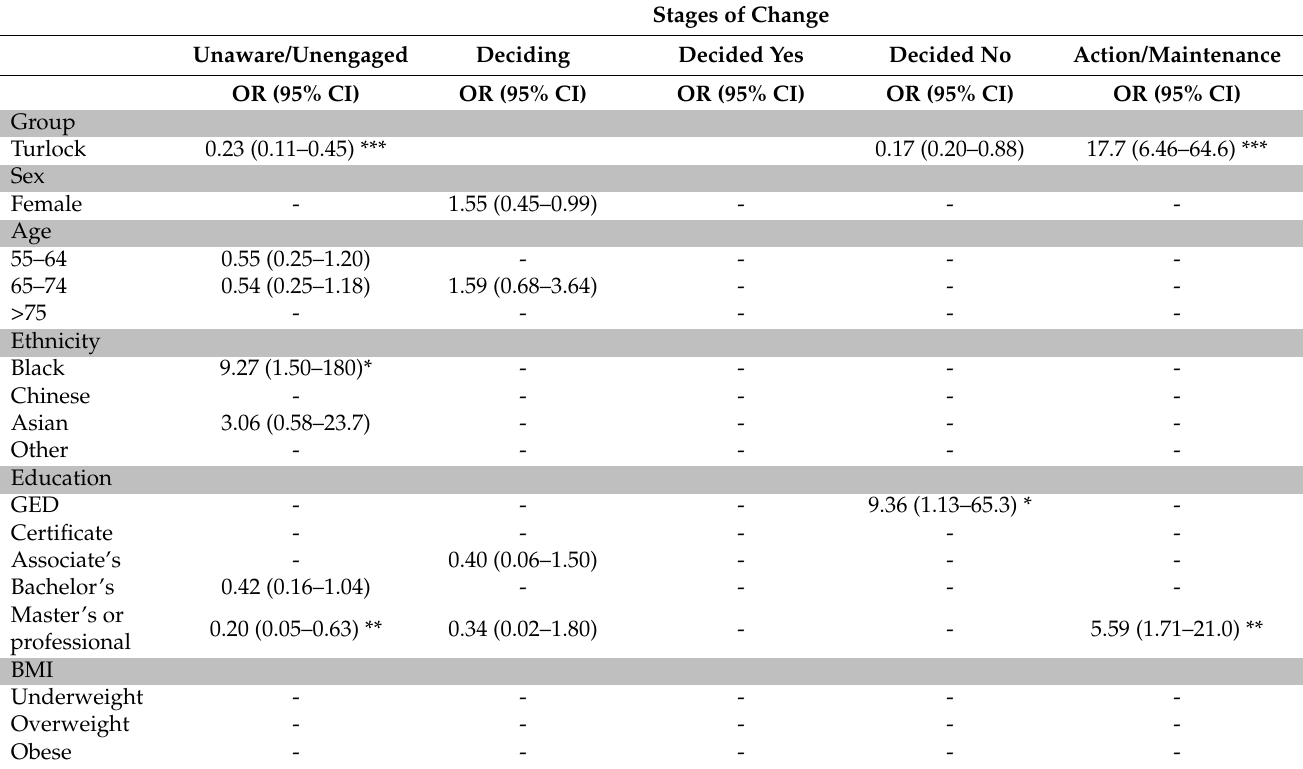
Table 6. Backward stepwise elimination logistic regression of stage of change by demographic factors. Stages of